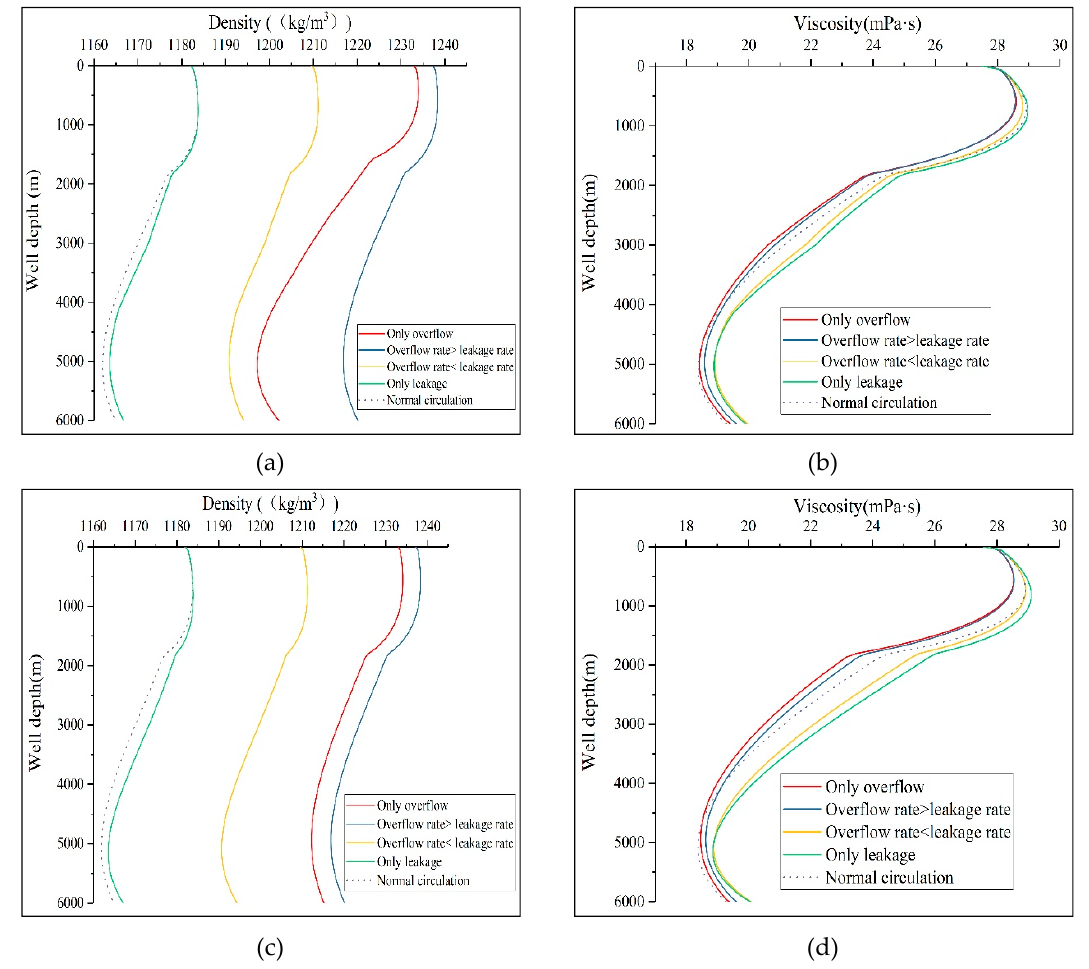
Figure 13. Variation of density and viscosity at di ff erent overflow and leakage rates. ( a ) Variation of density when the multi-pressure system is located in the middle formation; ( b ) Variation of viscosity when the multi-pressure system is located in the middle formation; ( c ) Variation of density when the multi-pressure system is located at bottom hole; ( d ) Variation of viscosity when the multi-pressure system is located at bottom